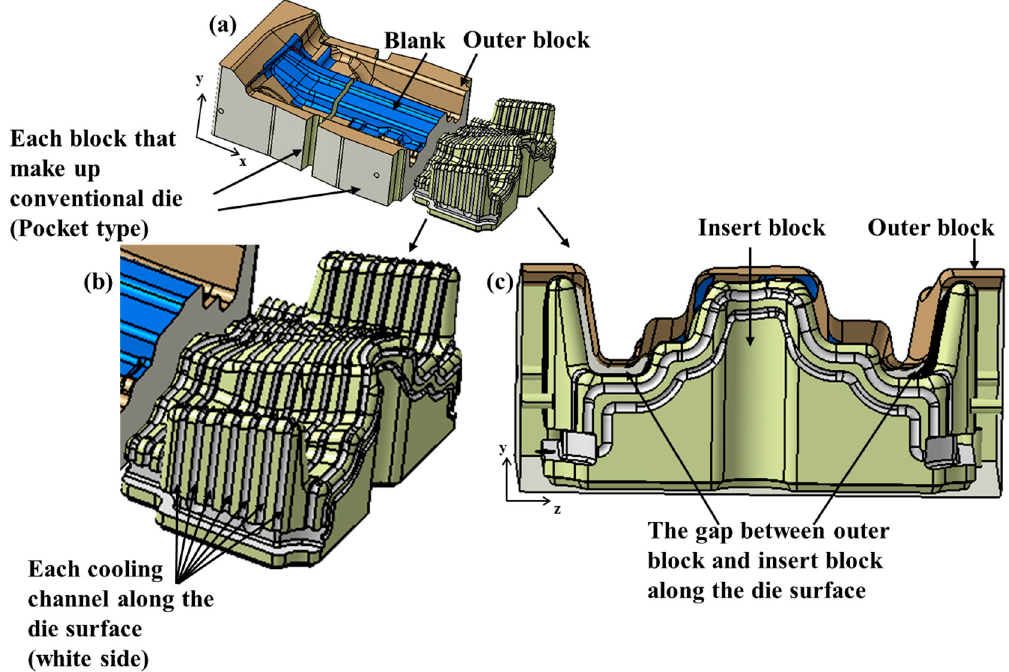
Figure 2. Conventional lower die (Pocket type): ( a ) Shape; ( b ) Cooling channel structure; ( c ) Insert and outer block.